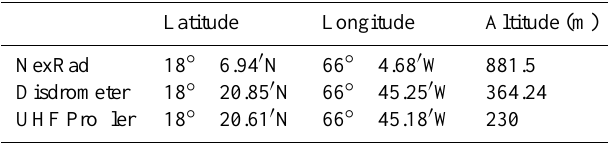
Table 1. Geographical coordinates of the different